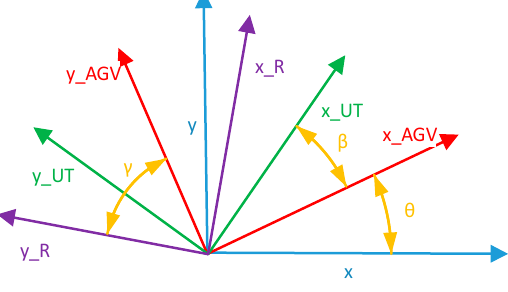
Figure 9. Reference system with trailer. The forces (green lines) applied to the trailer are represented in Figure